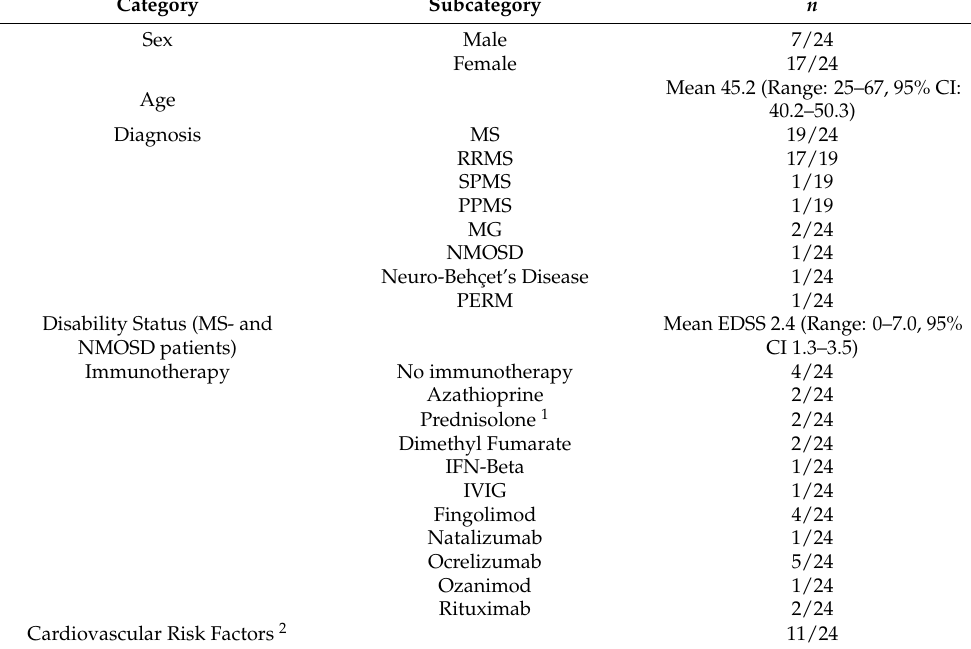
Table 1. Characteristics of our patient